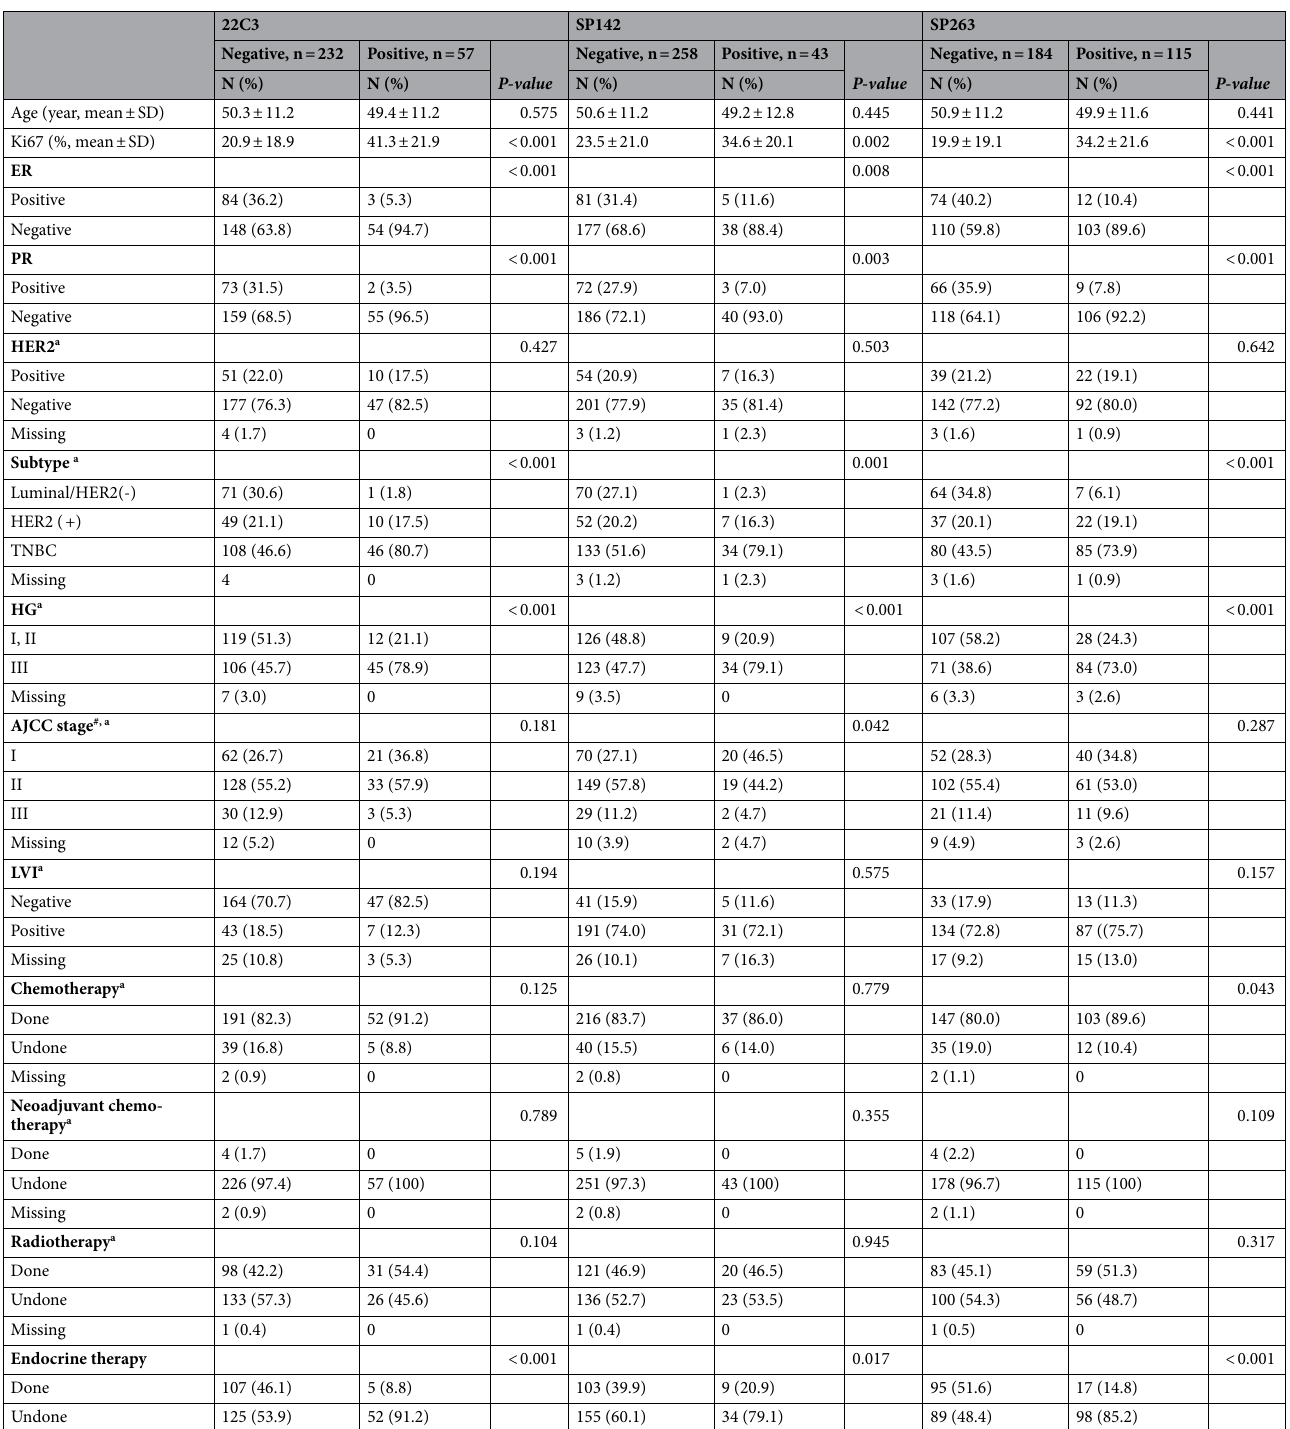
Table 1. Comparison of patient and tumor characteristics, and PD-L1 status in patients with breast cancer. SD, standard deviation; ER, estrogen receptor; PR, progesterone receptor; HER-2, human epidermal